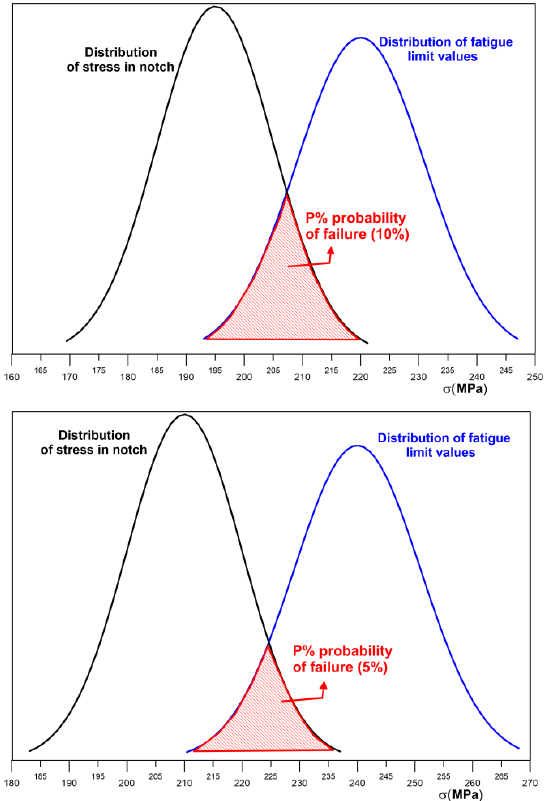
Figure 14. Graphical expression of possibilities reducing the fatigue fracture risk of press bar.